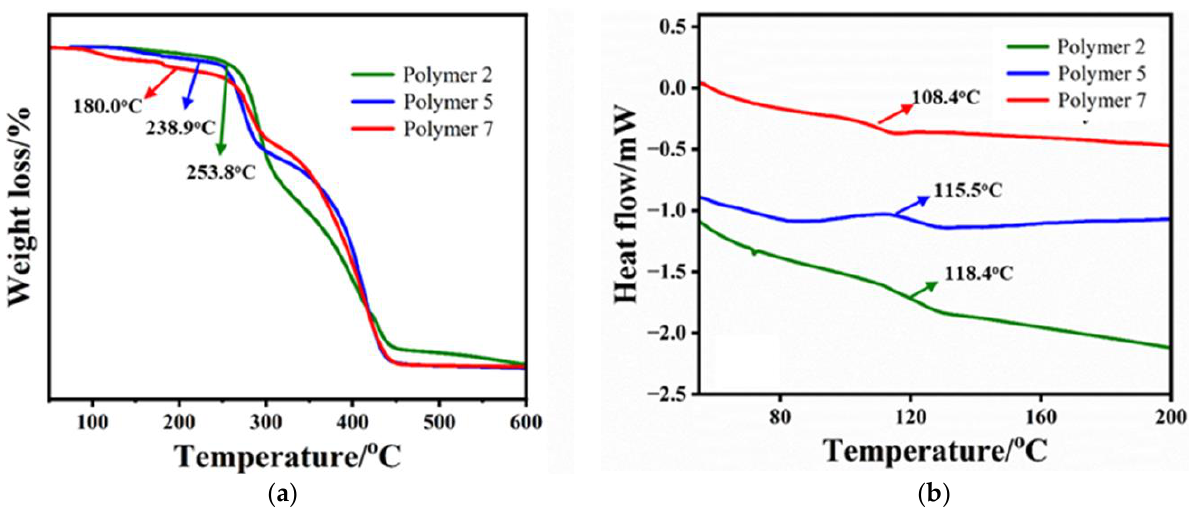
Figure 3. The effect of molecular weight on their thermal properties: ( a ) TGA curves; ( b ) DSC curve.